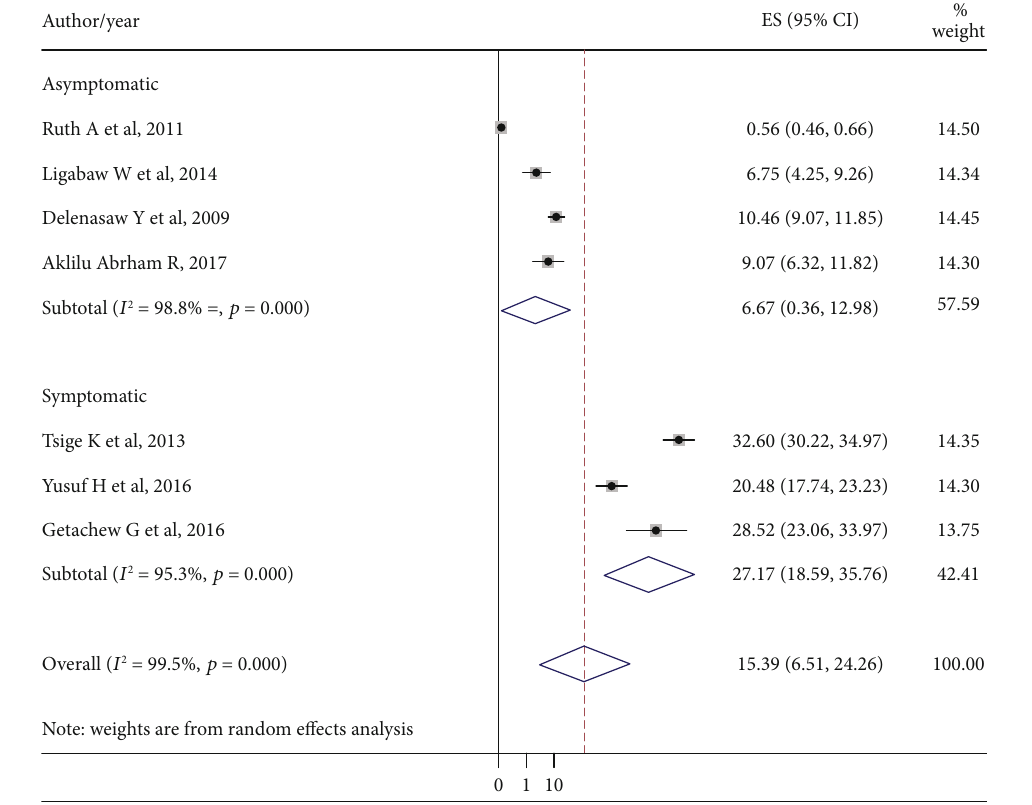
Figure 2: The pooled prevalence of malaria among children from random-e ff ects